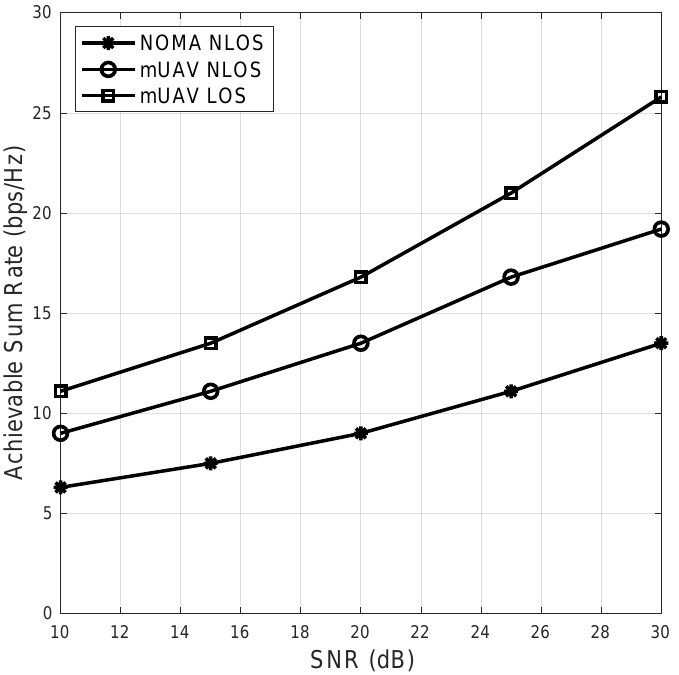
Figure 4. Comparison between multi-UAV-aided NOMA and terrestrial NOMA cellular